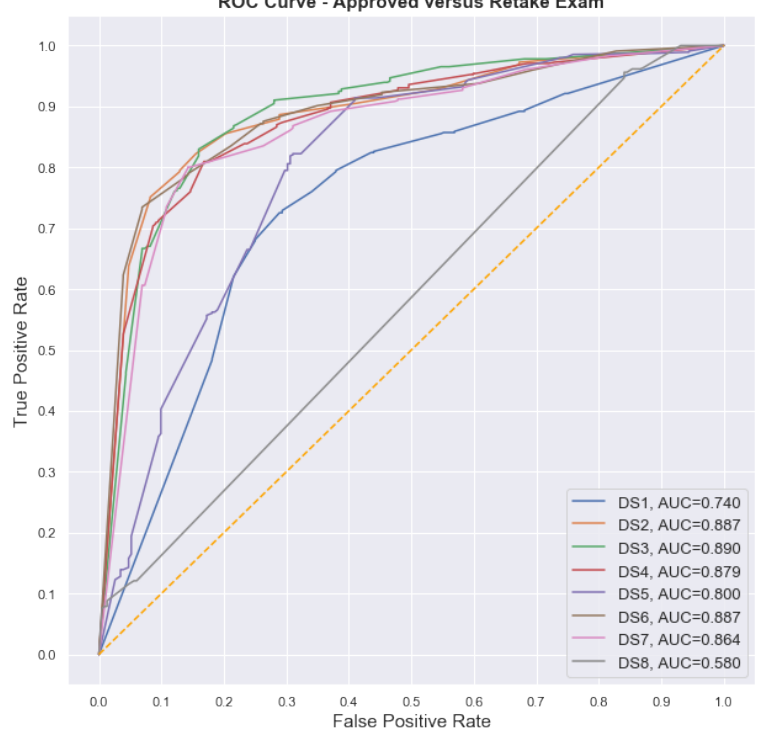
Figure 10. ROC Success in a